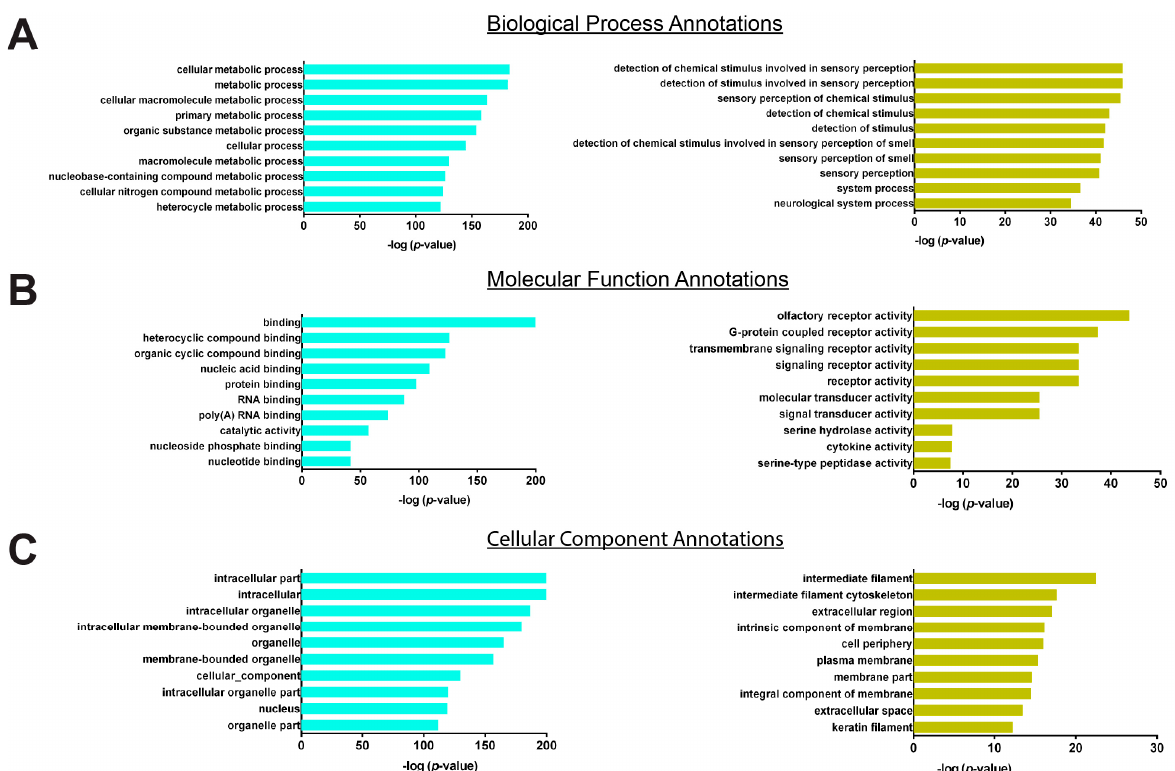
Figure 4. The top 10 gene ontology annotations in turquoise and yellow modules. The turquoise color denotes the turquoise module; the yellow color denotes the yellow module. ( A ) The top 10 Biological Process Annotations in turquoise and yellow modules. ( B ) The top 10 Molecular Function Annotations in turquoise and yellow modules. ( C ) The top 10 Cellular Component Annotations in turquoise and yellow modules.